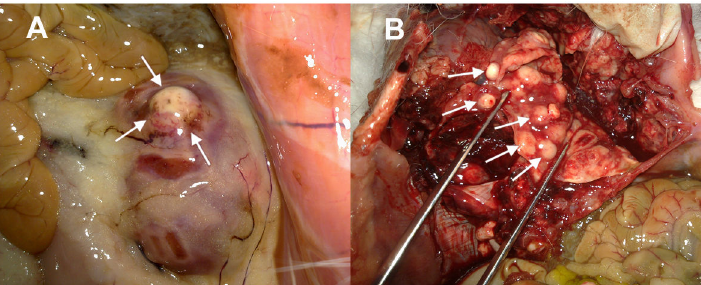
Figure 4. The macroscopic appearance of extra-hepatic metastases. A shows the renal metastases on day 42 after dissection of a rabbit in the cell suspension group (white arrow); B shows multiple pulmonary metastases on day 44 after dissection of another rabbit in the cell suspension group (white arrow).